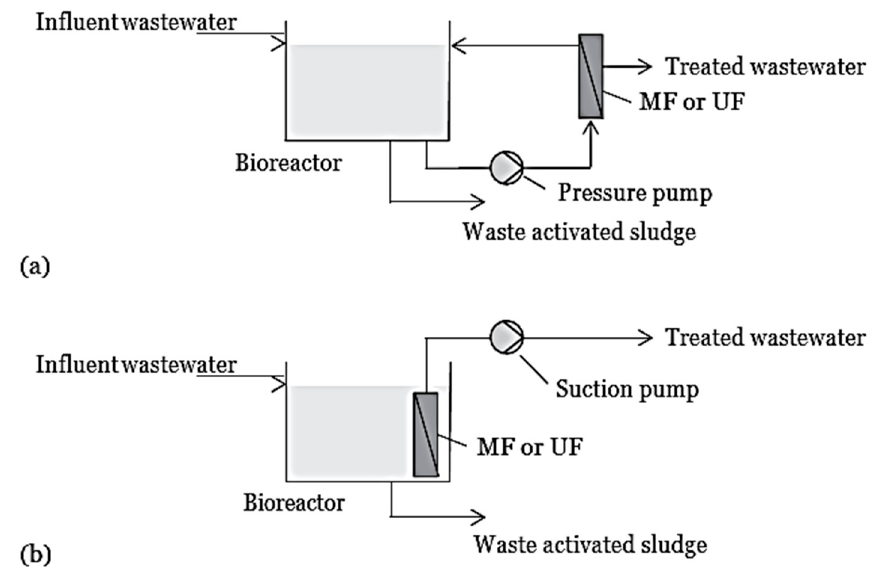
Figure 6. Two operational types of MBR technology: ( a ) side-stream configuration and ( b ) submersed configuration [5,51].